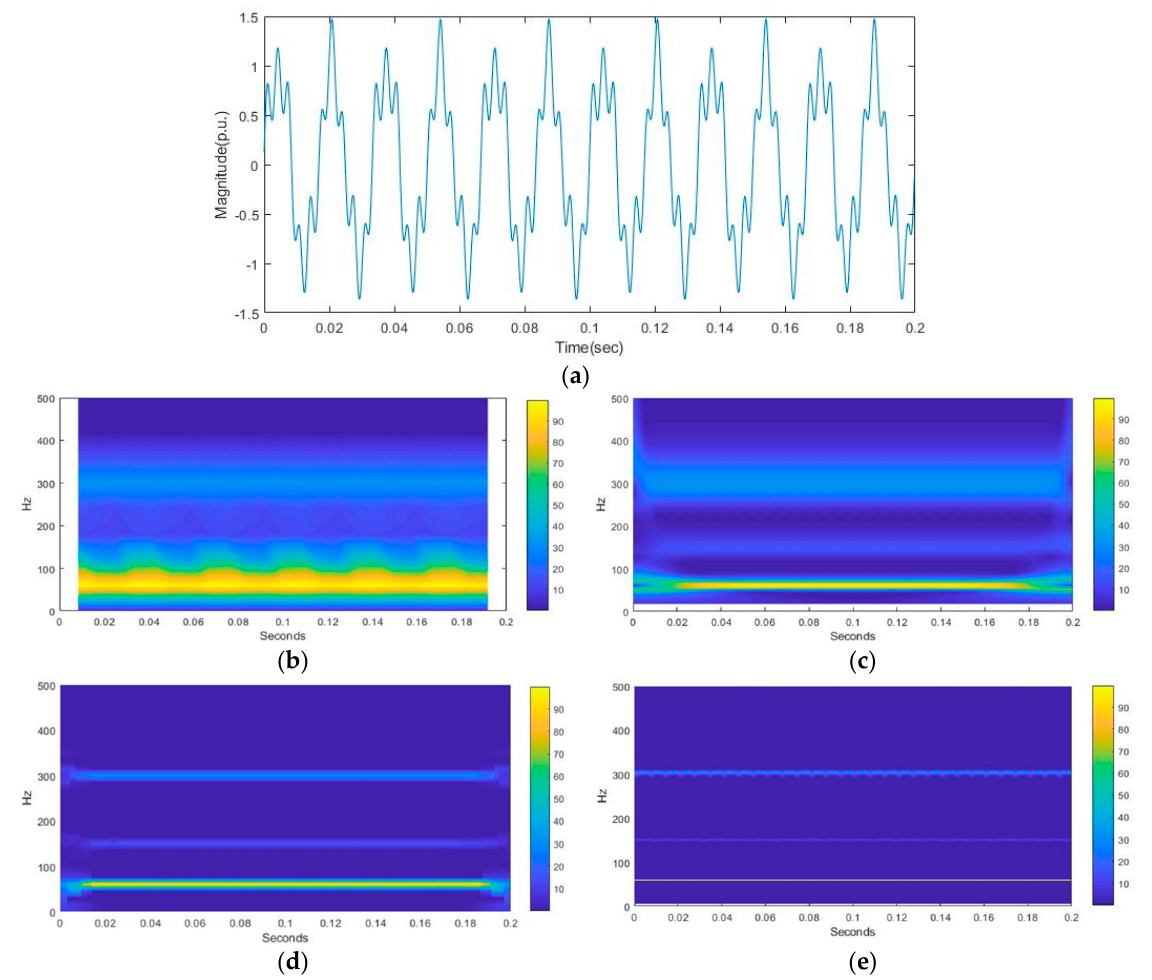
Figure 6. Performances of detection for multiple frequency components signal of (13): ( a ) frequency-modulated signal, and results of ( b ) STFT, ( c ) CWT, ( d ) FSST, ( e ) SSWT.